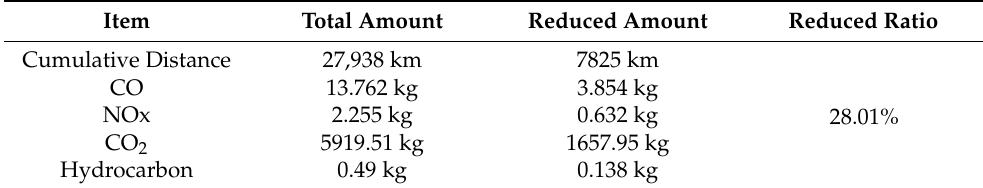
Table 5. Emissions reduced by shuttle service in one day.